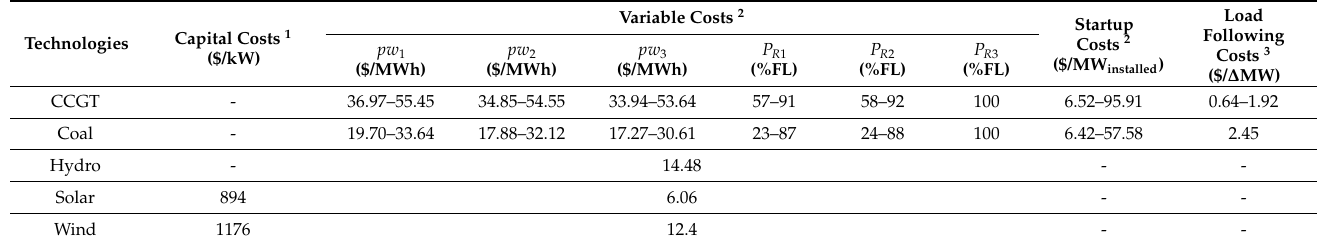
Table 2. Summary of generation costs.